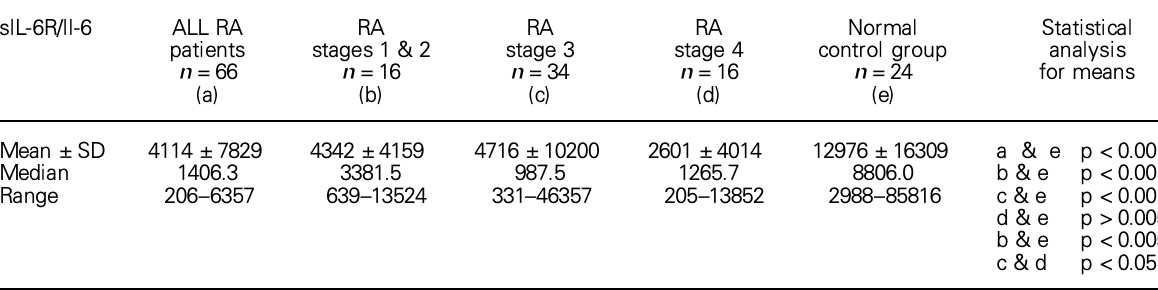
Table 3. Serum sIL-6R/II-6 ratio in the patients with RA according to disease activity according to Mallya and Mace